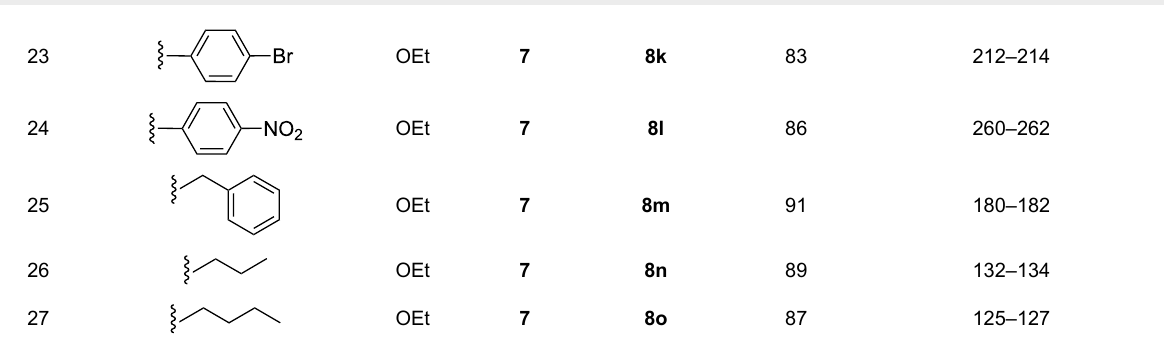
Table 2: Formation of isocoumarins 5 and 8 from adducts 6 and 7 respectively on an SSA surface.